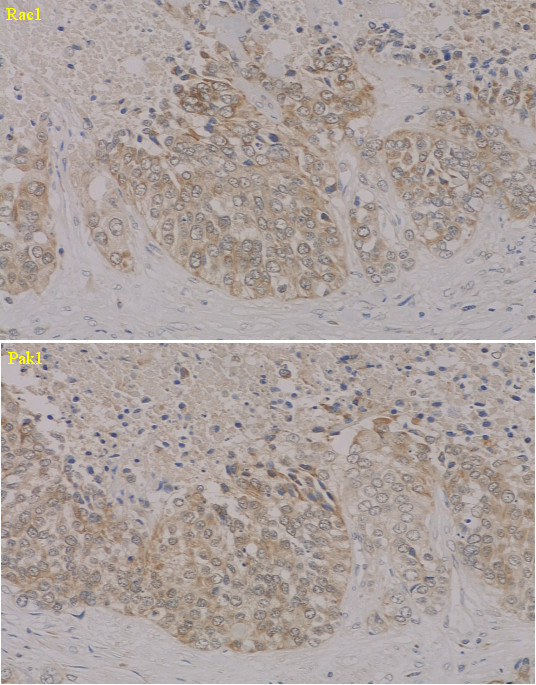
Immunohistochemistry for Rac1 (upper panel) and Pak1 (lower panel) proteins in Grade 3 carcinoma. Cytosolic compartments shows intensely brown staining in most of the cancer cells, displaying high Rac1 and Pak1 protein levels, but the nuclei of the cancer cells shows very weak staining.